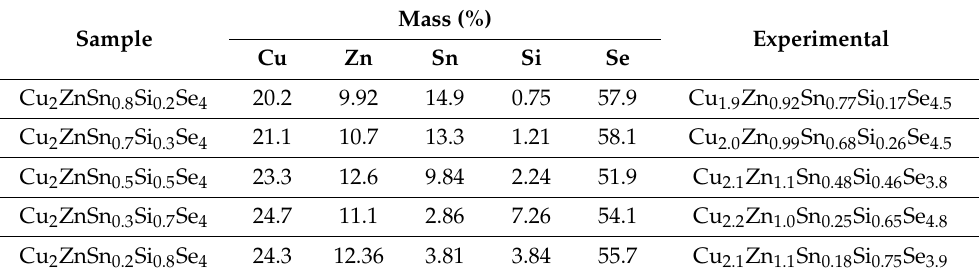
Table 2. Chemical composition of the samples Cu 2 ZnSn 1 − x Si x Se 4 .